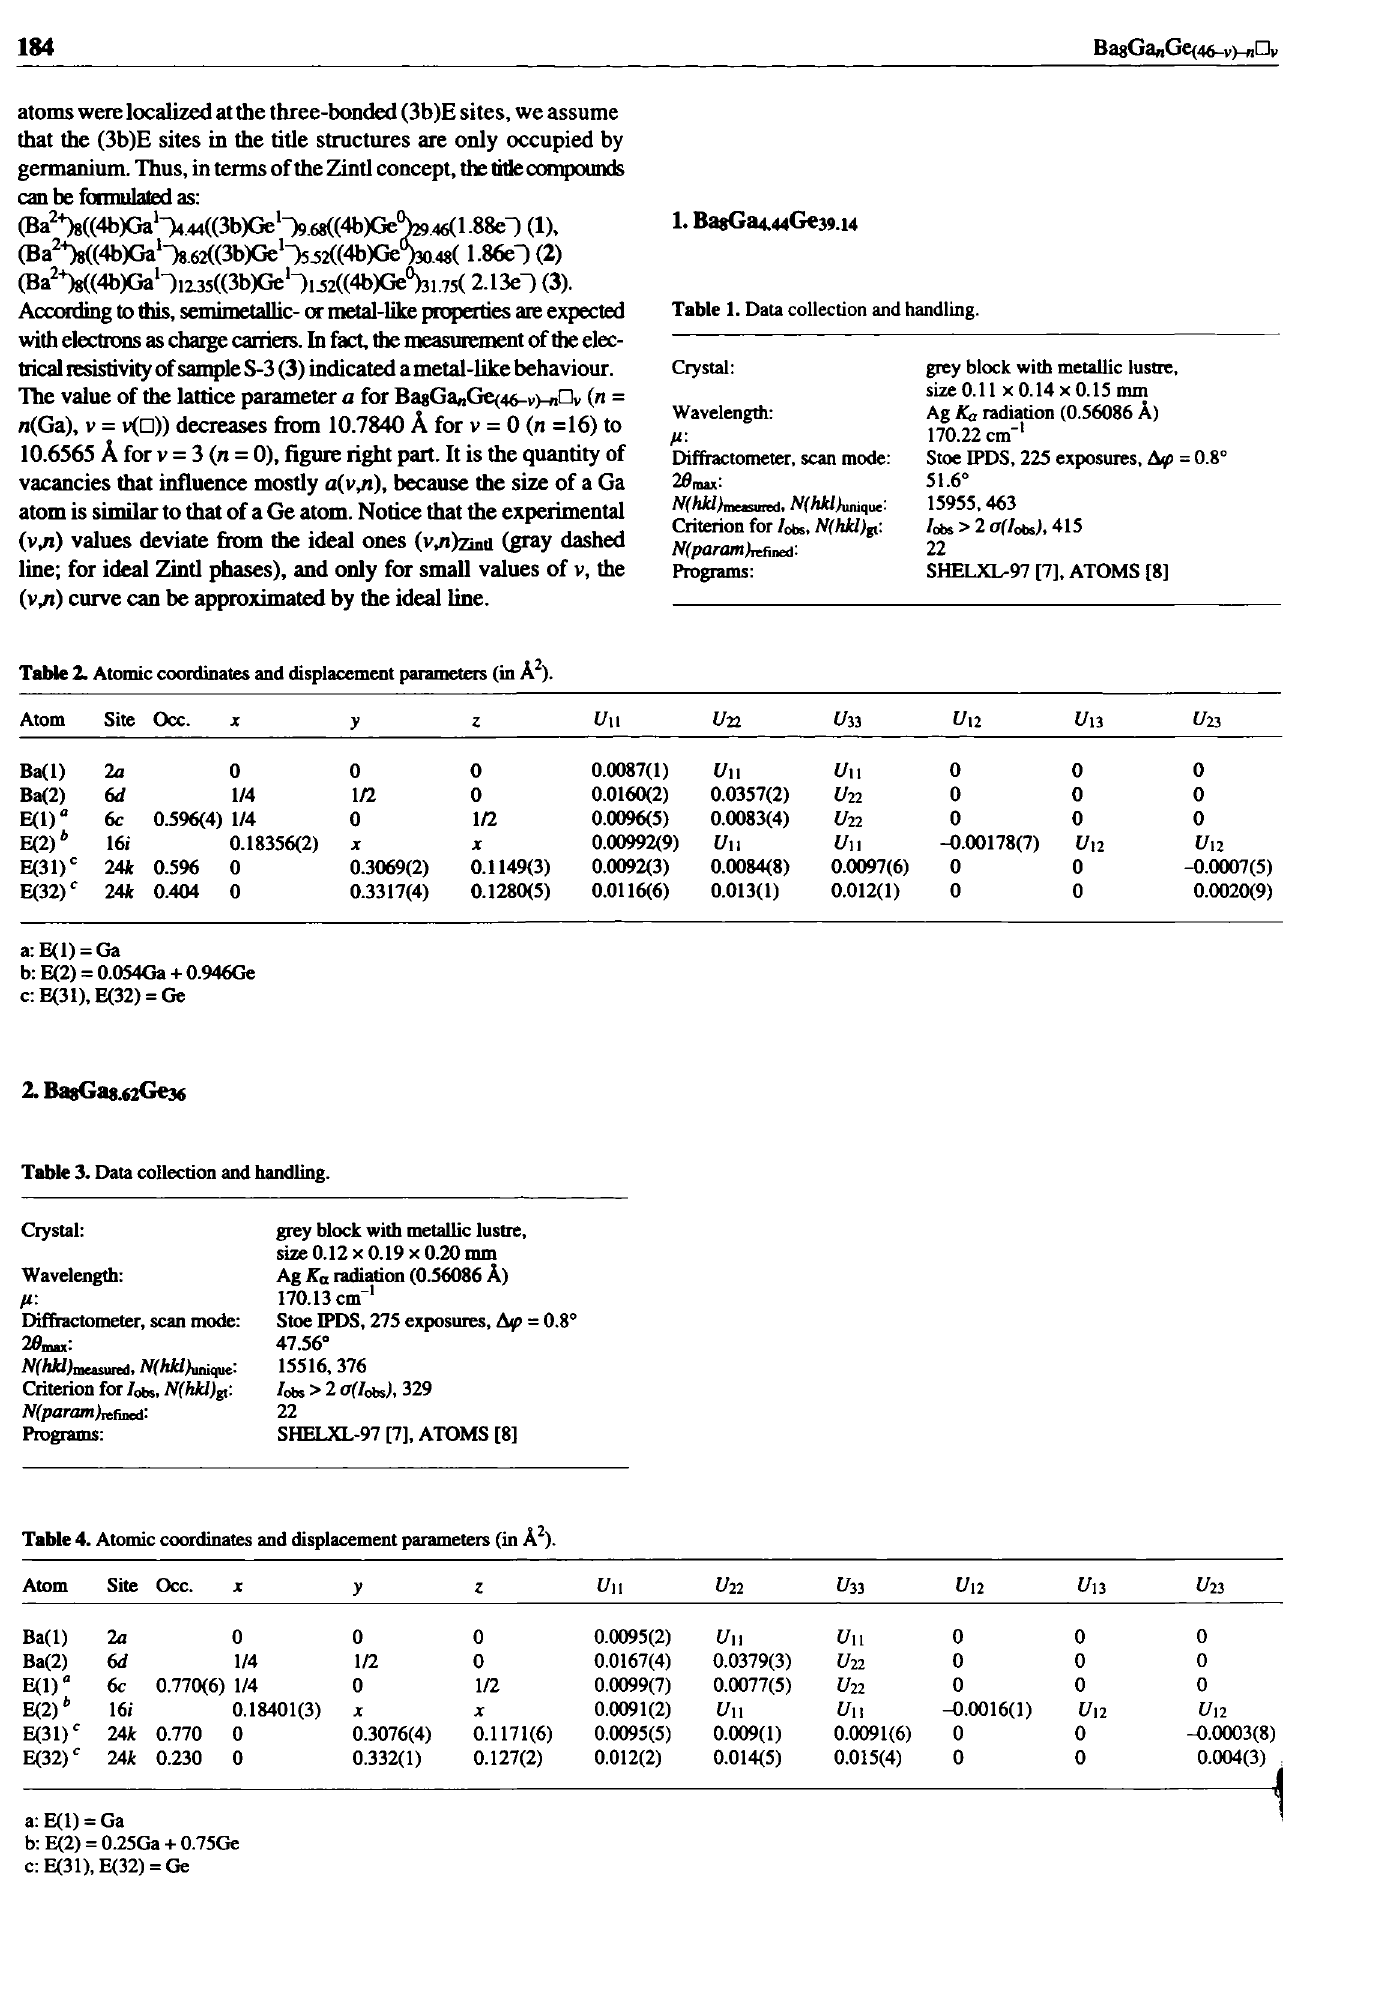
Table 1. Data collection and handling.